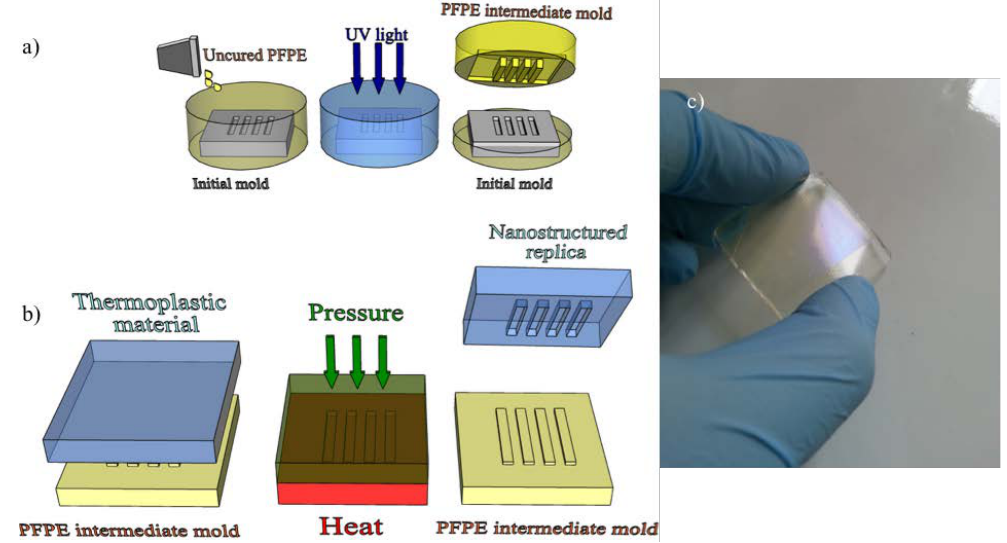
Figure 2. Schematic illustration of ( a ) PFPE intermediate mold fabrication and ( b ) subsequent thermal NIL process made by using the PFPE intermediate mold. The thermoplastic material used in this study is COC. ( c ) Photo of a PFPE intermediate mold.